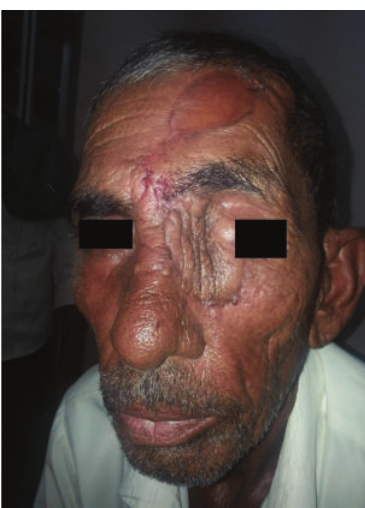
Figure 3: Reconstruction using forehead flap with SSG closure. Figure 4: Reconstruction using forehead flap with primary closure.